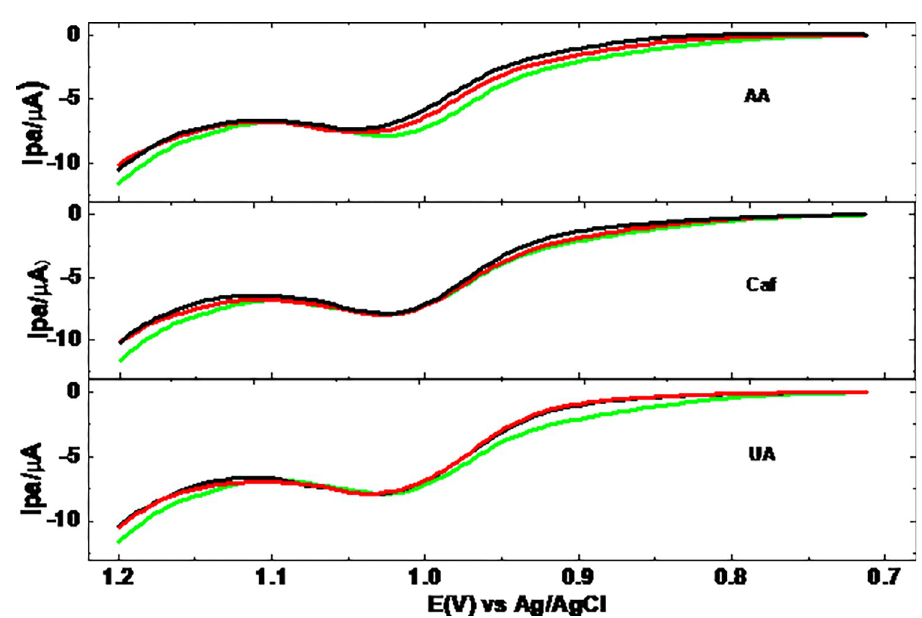
Fig 13. Square wave voltammograms of tablet sample in the presence of 0.0, 20.0, and 40.0 μ M of AA, Caf, or